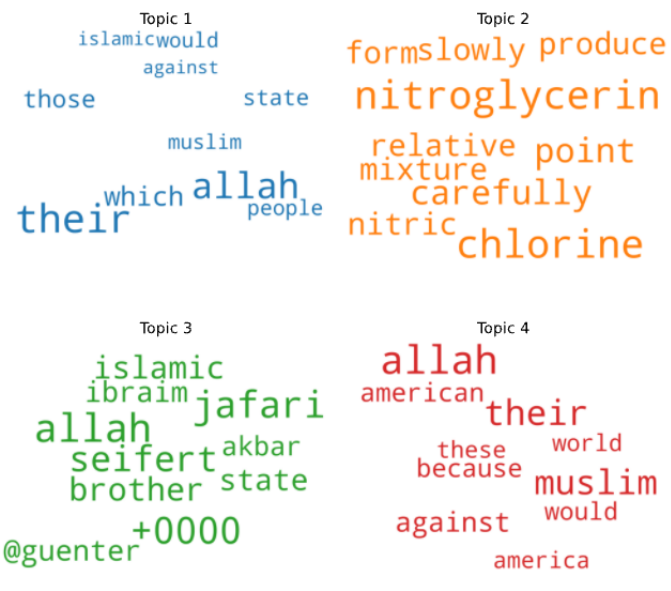
Figure 7. Topic models that were estimated from the dataset, which was introduced in Section 4.1. Each topic is displayed in a specific colour and the size of the word expresses it